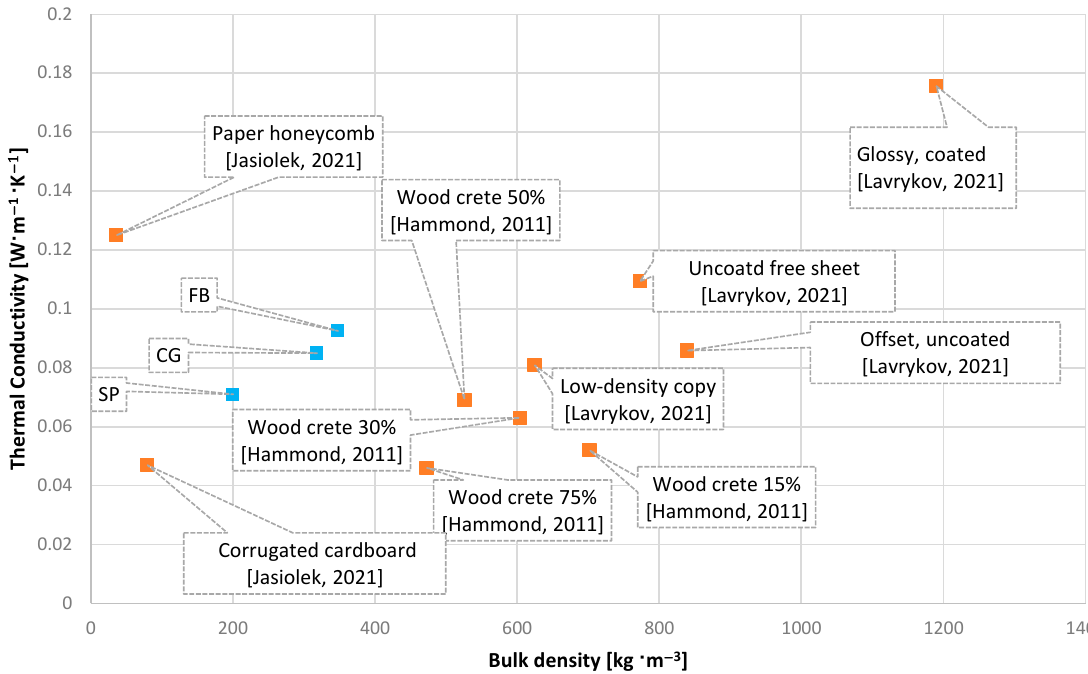
Figure 6. Comparison of thermal conductivity between tested samples and paper-based components, taken from the literature (Hammond et al. [25], Jasoliek et al. [74], Lavrykov et al. [75]).